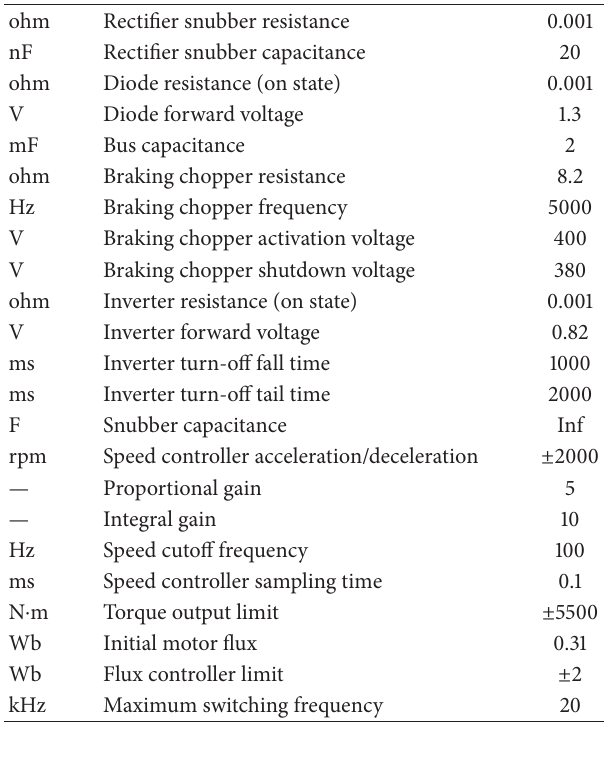
Table 2: Physical and simulation parameters for controller and inverter.